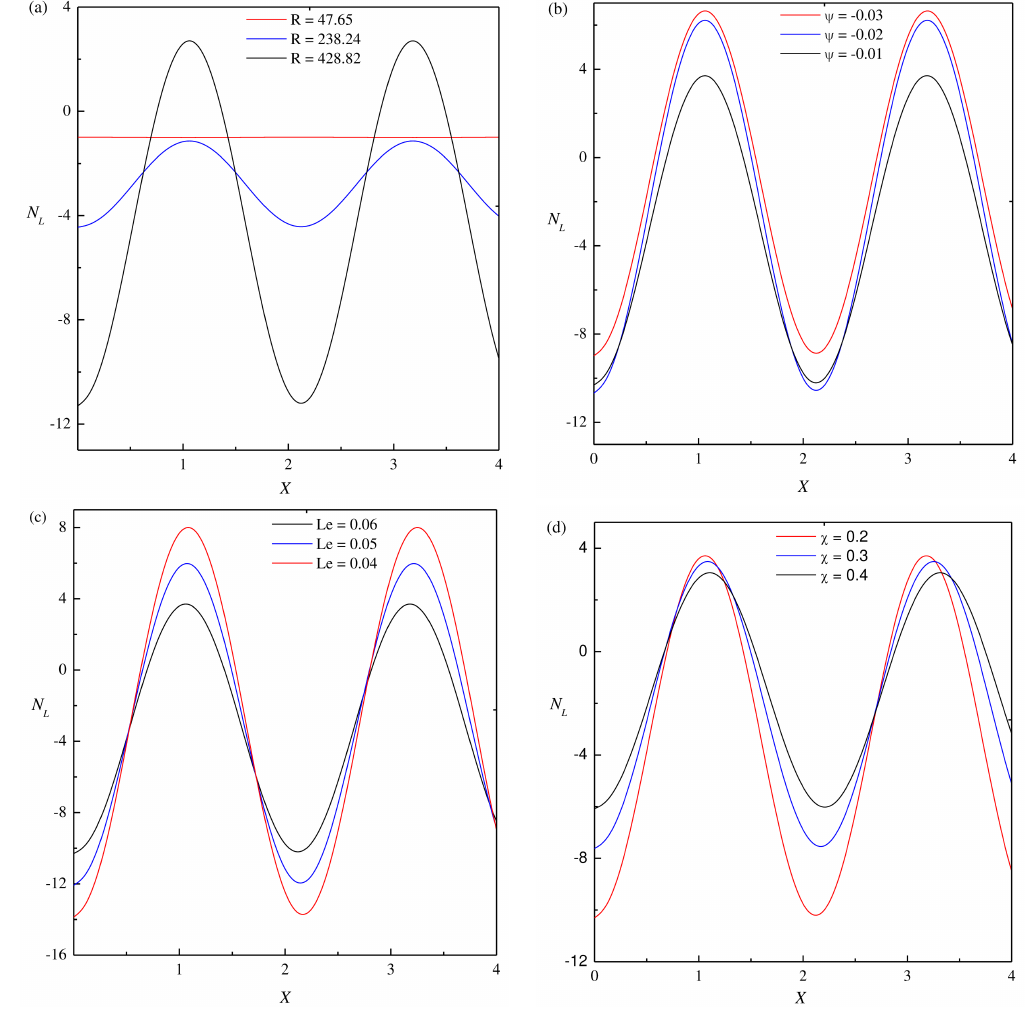
Figure 4. Variation of N L with respect to X with R = 3 R co and t = 0.1. ( a ) ψ = − 0.03, Le = 0.04, χ = 0.2 for different R ( b ) Le = 0.04, χ = 0.2 for different ψ , ( c ) ψ = − 0.03, χ = 0.2 for different Le , ( d ) ψ = − 0.03, Le = 0.04 for different χ .